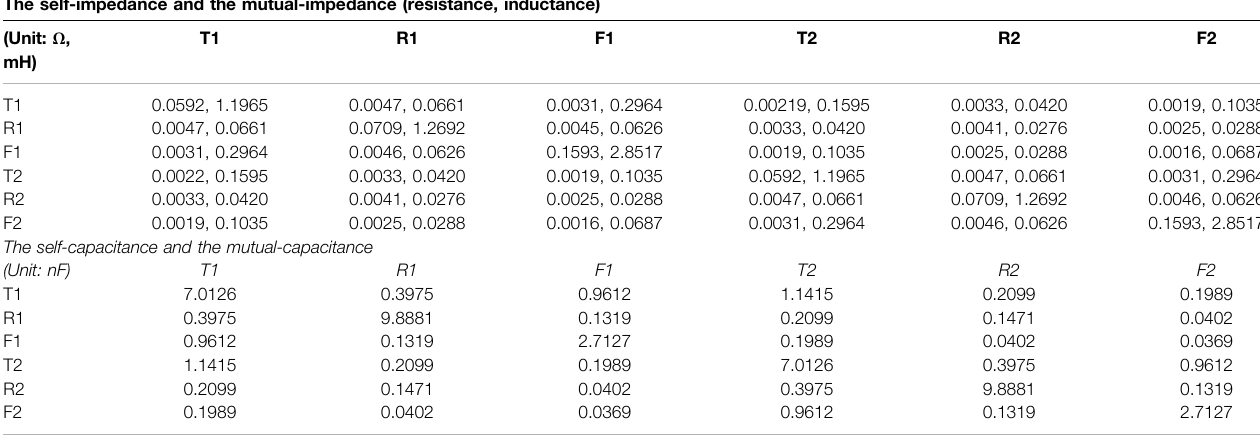
TABLE A1 | The parameters of the 6-conductor lines simulation model. The self-impedance and the mutual-impedance (resistance,